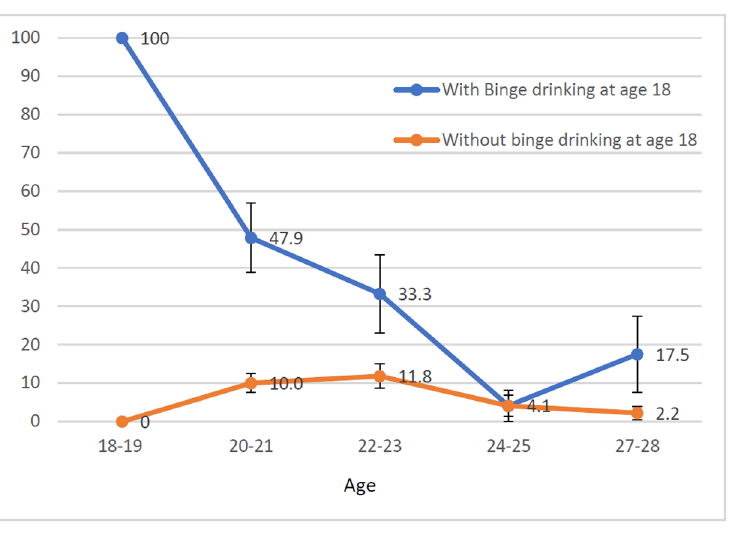
Fig 2. Trends in prevalence of binge drinking (%) among women who already partook and who did not partake in binge drinking at age 18–19. https://doi.org/10.1371/journal.pone.0193741.g002 PLOS ONE | https://doi.org/10.1371/journal.pone.0193741 April 9,